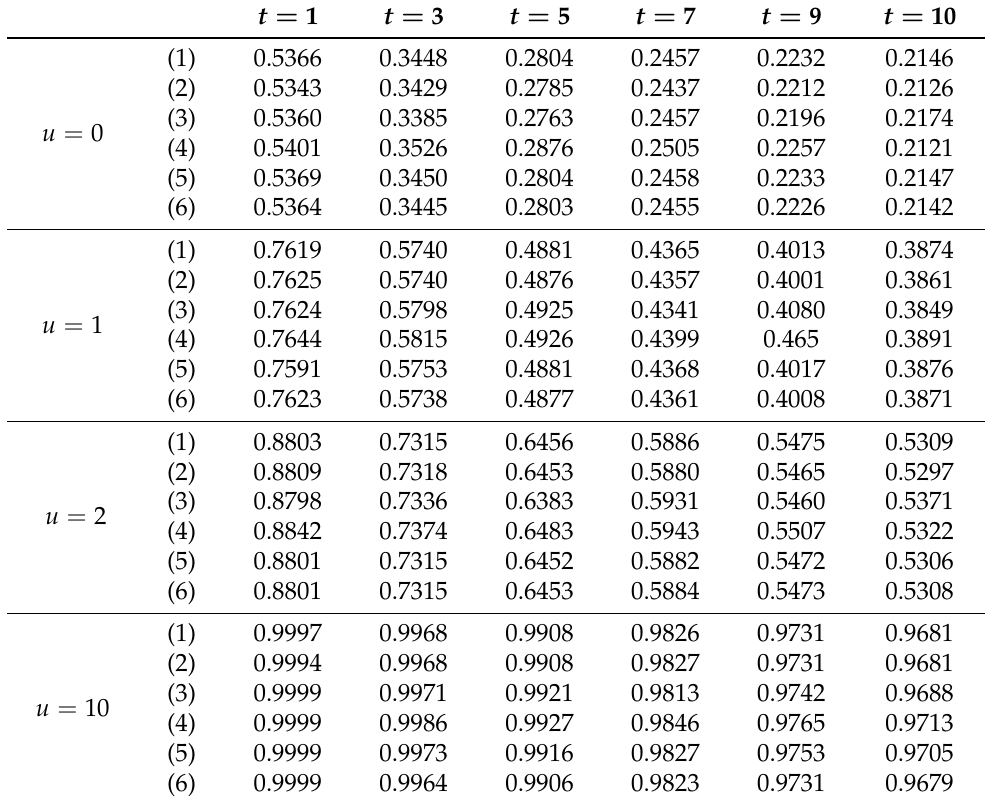
Table 1. Approximated finite-time survival probabilities with exponential claims for different time horizons ( t = 1,3,5,7,9,10 ) with various initial reserves ( u = 0,1,2,10 )